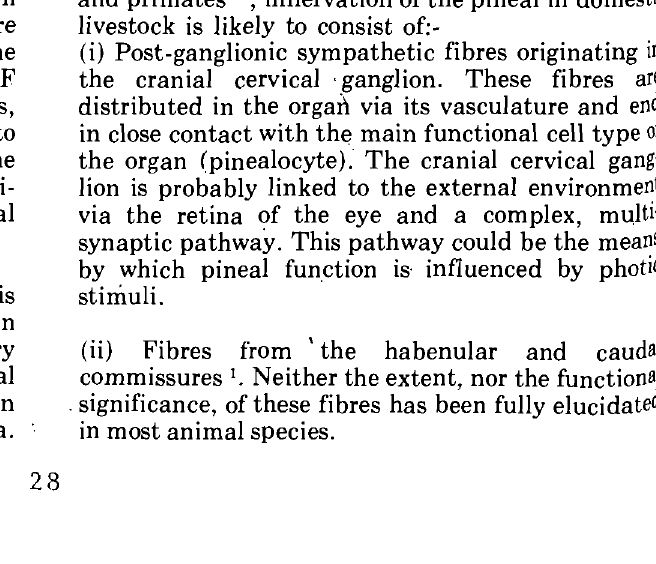
Fig. 1: Anatomical Relationships of Pineal